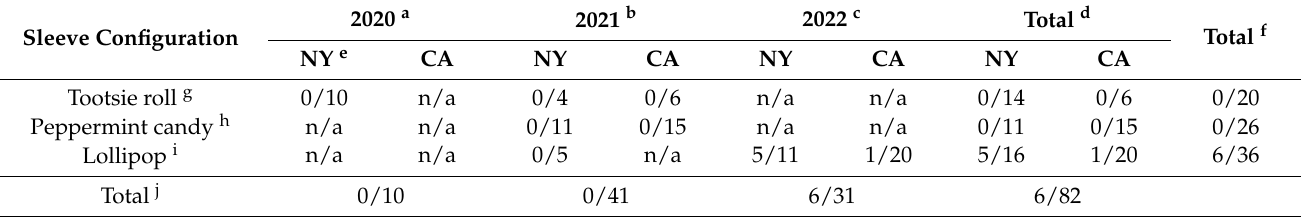
Table 1. Transmission of grapevine red blotch virus (GRBV) to grapevines in a New York and a California vineyard by Spissistilus festinus using various sleeve configurations for inoculation after a two-week acquisition period on infected Phaseolus vulgaris